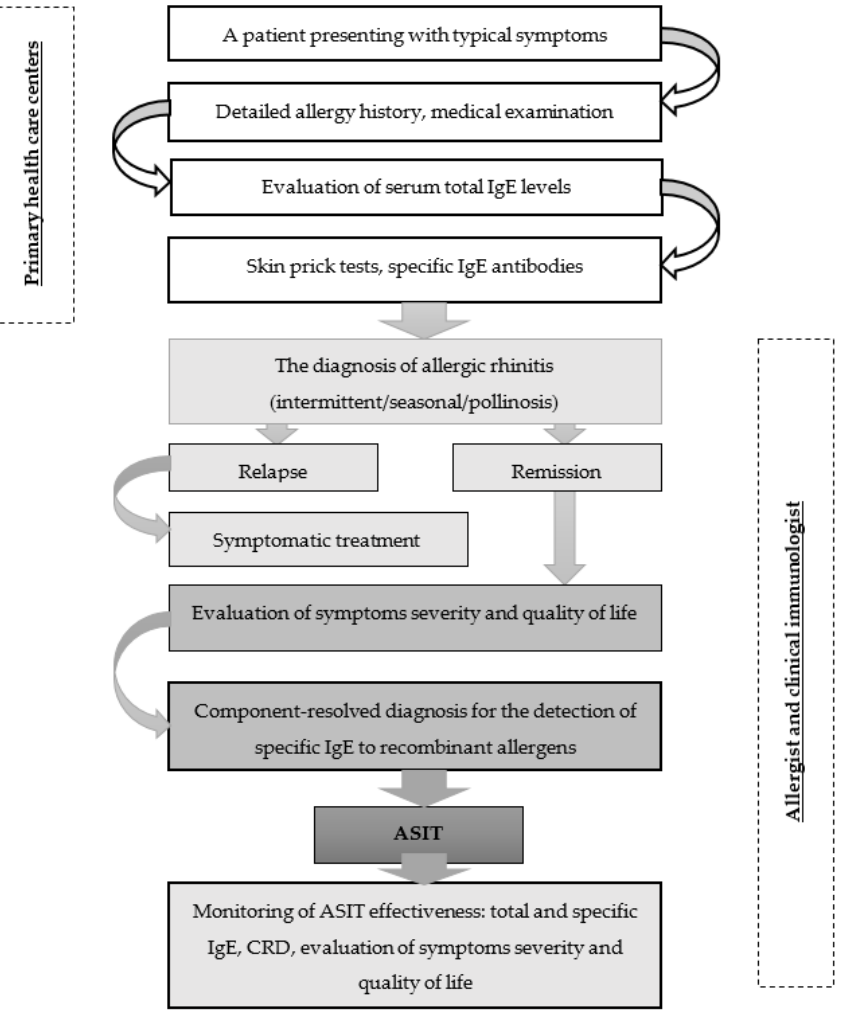
Figure 2. Management algorithm for patients with seasonal allergic rhinitis.